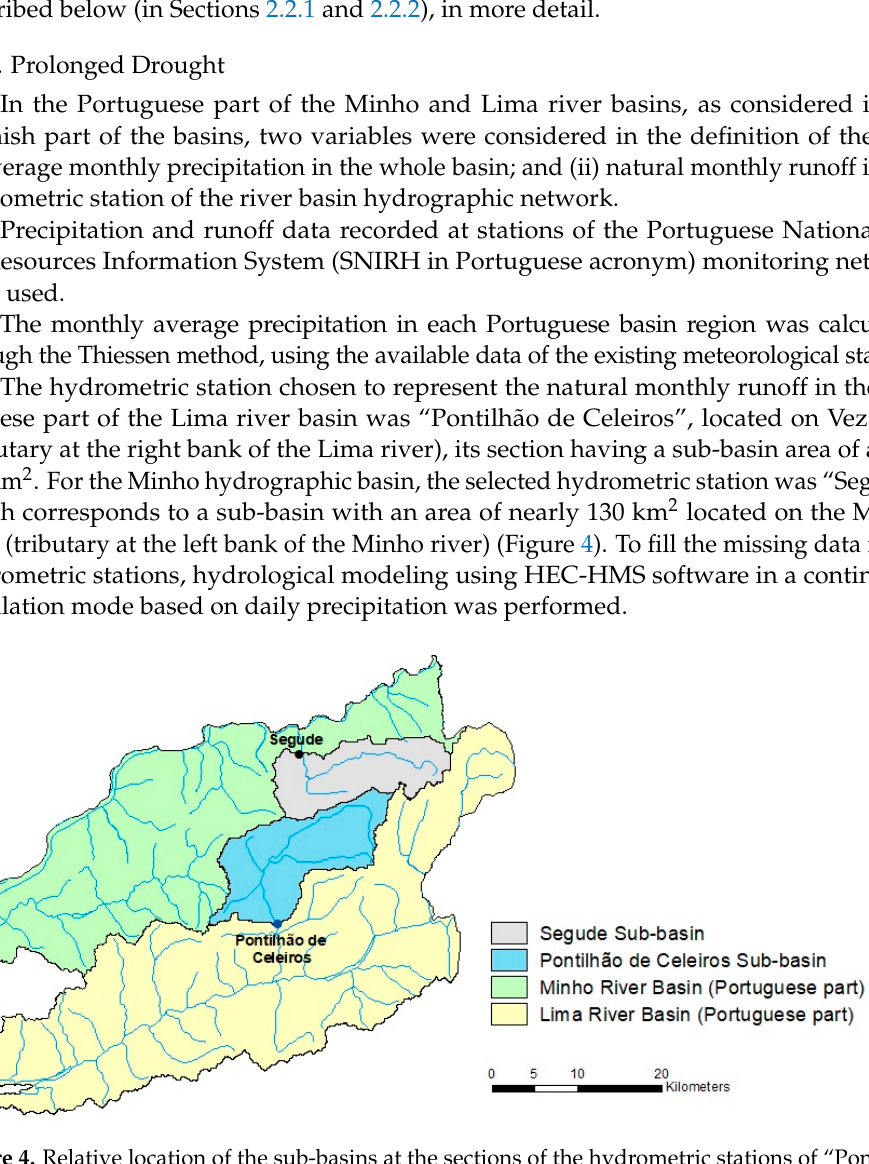
Figure 4. Relative location of the sub-basins at the sections of the hydrometric stations of “Pontilhão de Celeiros” (in the Lima river basin) and “Segude” (in the Minho river basin).